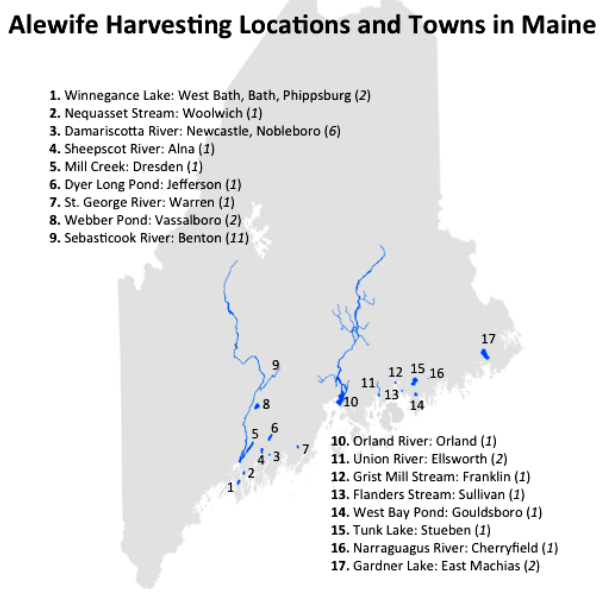
Fig. 1. Alewife ( Alosa pseudoharengus ) harvesting